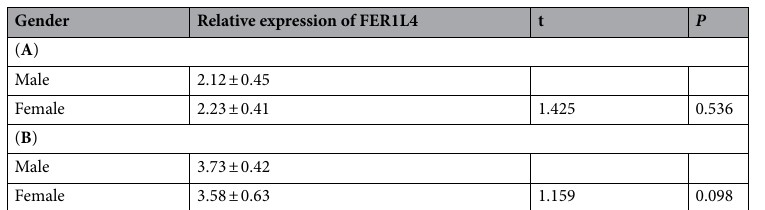
Table 5. No difference of FER1L4 expression was detected between in male or female specimens. (A) Relative levels of FER1L4 expression in male or female OA patients. (B) Relative levels of FER1L4 expression in male or female healthy controls. * P <